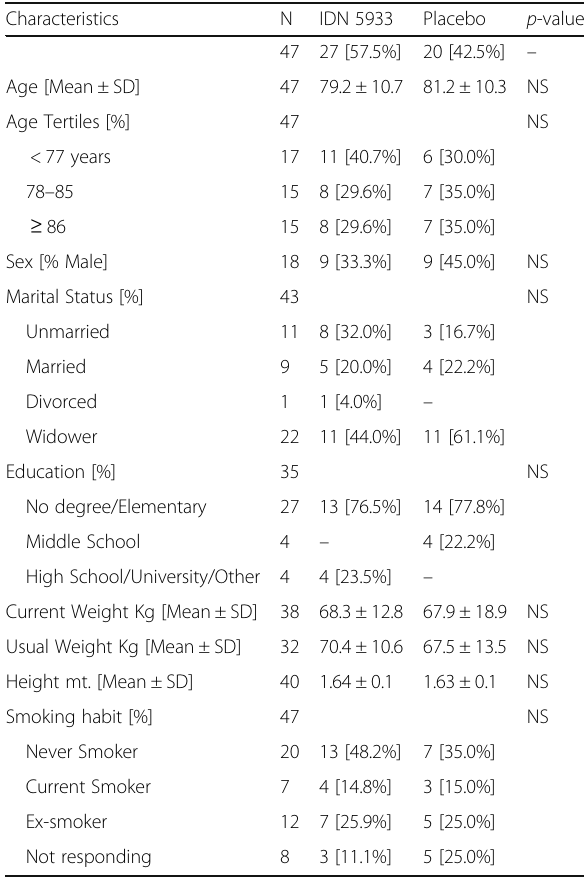
Table 1 Distribution of participants to the GIBIEX study according to main individual characteristics at enrollment